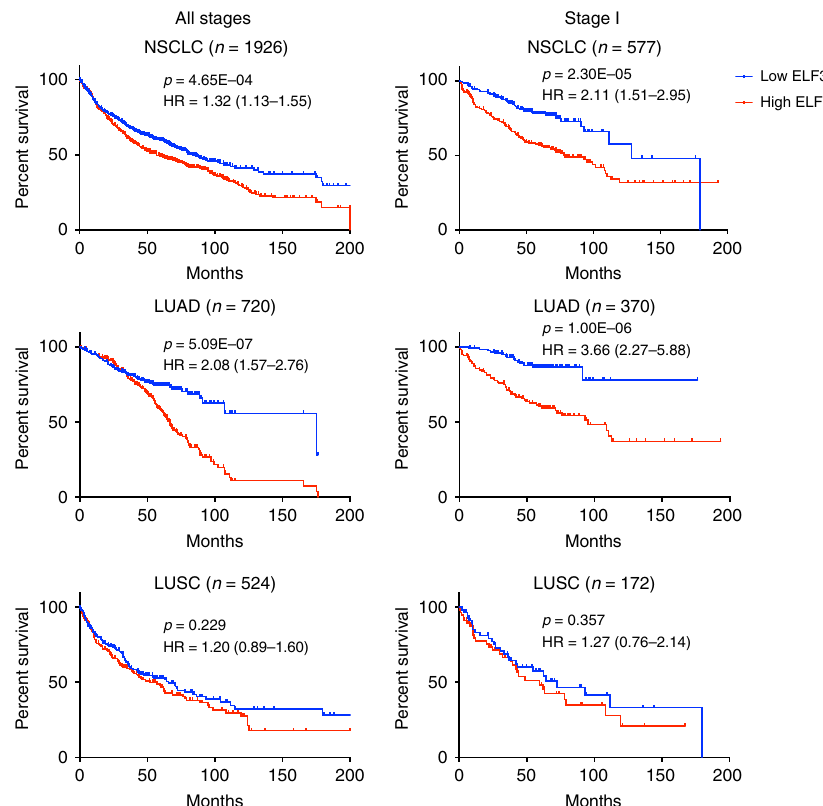
Fig. 6 Prognostic relevance of ELF3 expression in non-small cell lung cancer. Kaplan – Meier survival curves comparing overall survival of lung cancer patients with high or low ELF3 expression (top and bottom tertiles, log-rank p values). All Stages: NSCLC n = 1926, p = 4.65E-04, Hazard Ratio (HR) (95% con fi dence interval) = 1.32 (1.13 – 1.55); LUAD n = 720, p = 5.09E-07, HR = 2.08 (1.57 – 2.76); LUSC n = 524, p = 0.229, HR = 1.20 (0.89 – 1.60). Stage I: NSCLC n = 577, p = 2.30E-05, HR = 2.11 (1.51 – 2.95); LUAD n = 370, p = 1.00E-06, HR = 3.66 (2.27 – 5.88); LUSC n = 172, p = 0.357, HR =